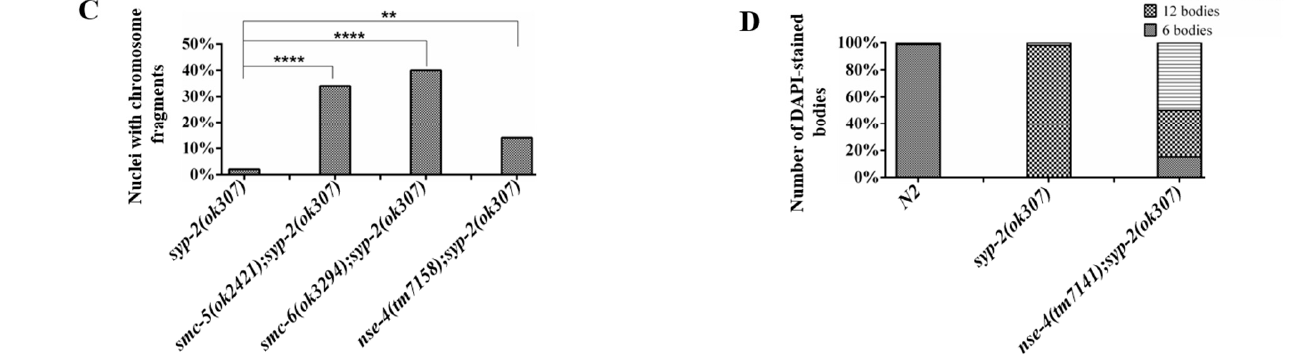
Figure 5. nse-4 mutants showed defective inter-sister repair. ( A ) Micrographs of the diakinesis chromosome with fragments (white arrows) in the double mutants. ( B ) Representative micrographs showing chromosome structure at diakinesis in nse-4(tm7158);syp-2(ok307) . Chromosome bodies are grossly damaged, but surprisingly, some nuclei showed wild-type phenotype. ( C ) Quantification of chromosome fragments at diakinesis (** p < 0.01, **** p < 0.0001, chi-square Fisher’s Exact Test). The sample size ( n ) = 200 for each genotype. Chromosome fragments were scored using Leica DM6 B at 100× objective with oil immersion. ( D ) Quantification of DAPI-stained bodies of nse-4(tm7141);syp-2(ok307) diakinesis nuclei. Nse-4(tm7141) mutation rescued about 15% of the syp-2 diakinesis phenotype. The sample size ( n ) = 200 for each genotype. DAPI bodies were scored using Leica DM6 B at 100× objective with oil immersion. Images were captured using Zeiss confocal microscope LSM 800 with Airyscan at 63× objective with oil immersion (scale bar = 10 μ m).